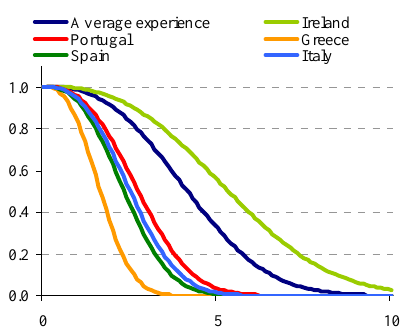
Figure 3: Factors affecting current probabilities of achieving long-lasting consolidation in selected euro area countries (contribution to estimated probability of consolidations starting